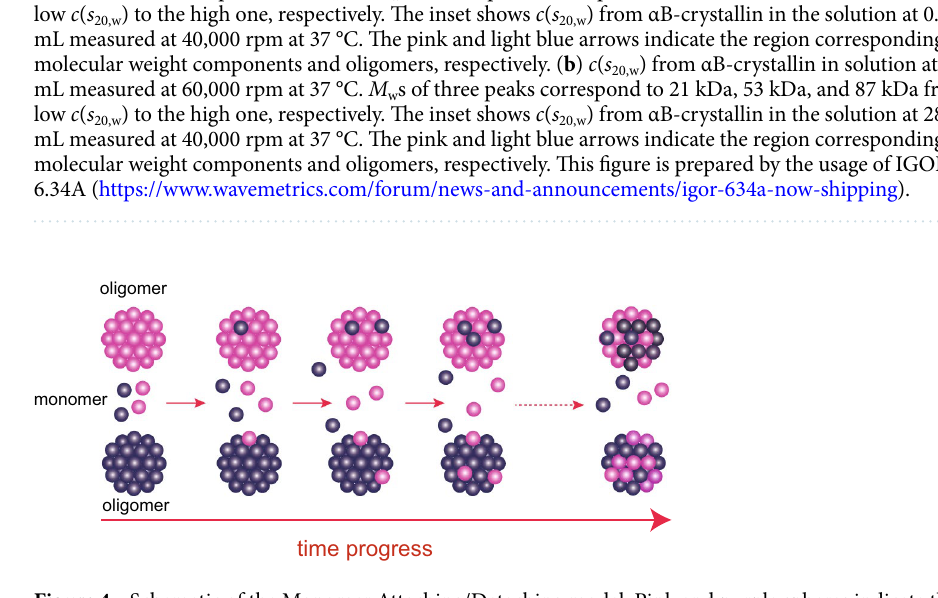
Figure 4. Schematic of the Monomer Attaching/Detaching model. Pink and purple spheres indicate the h- and p d-subunits, respectively. Large clusters and small spheres correspond to αB-crystallin oligomers and monomers, respectively. This figure is prepared by the usage of Adobe Illustrator CC 2015.2.1 (19.2.1) (https :// www.adobe .com/jp/produ cts/illus trato